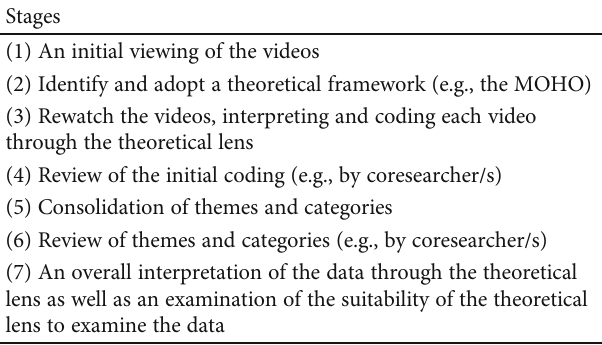
Table 1: Seven stages of theoretical video